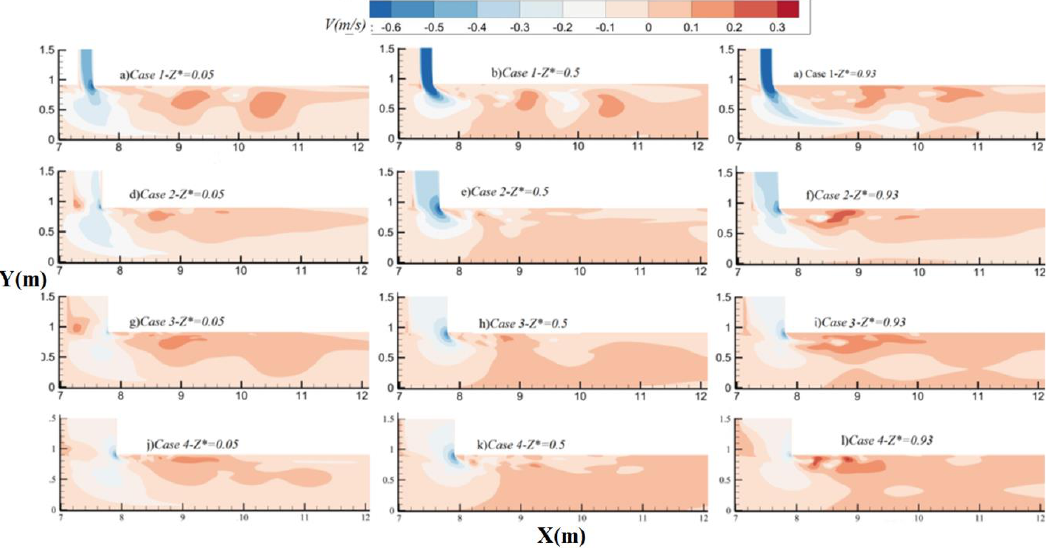
Figure 5. The distribution of the normal component of velocity (V).